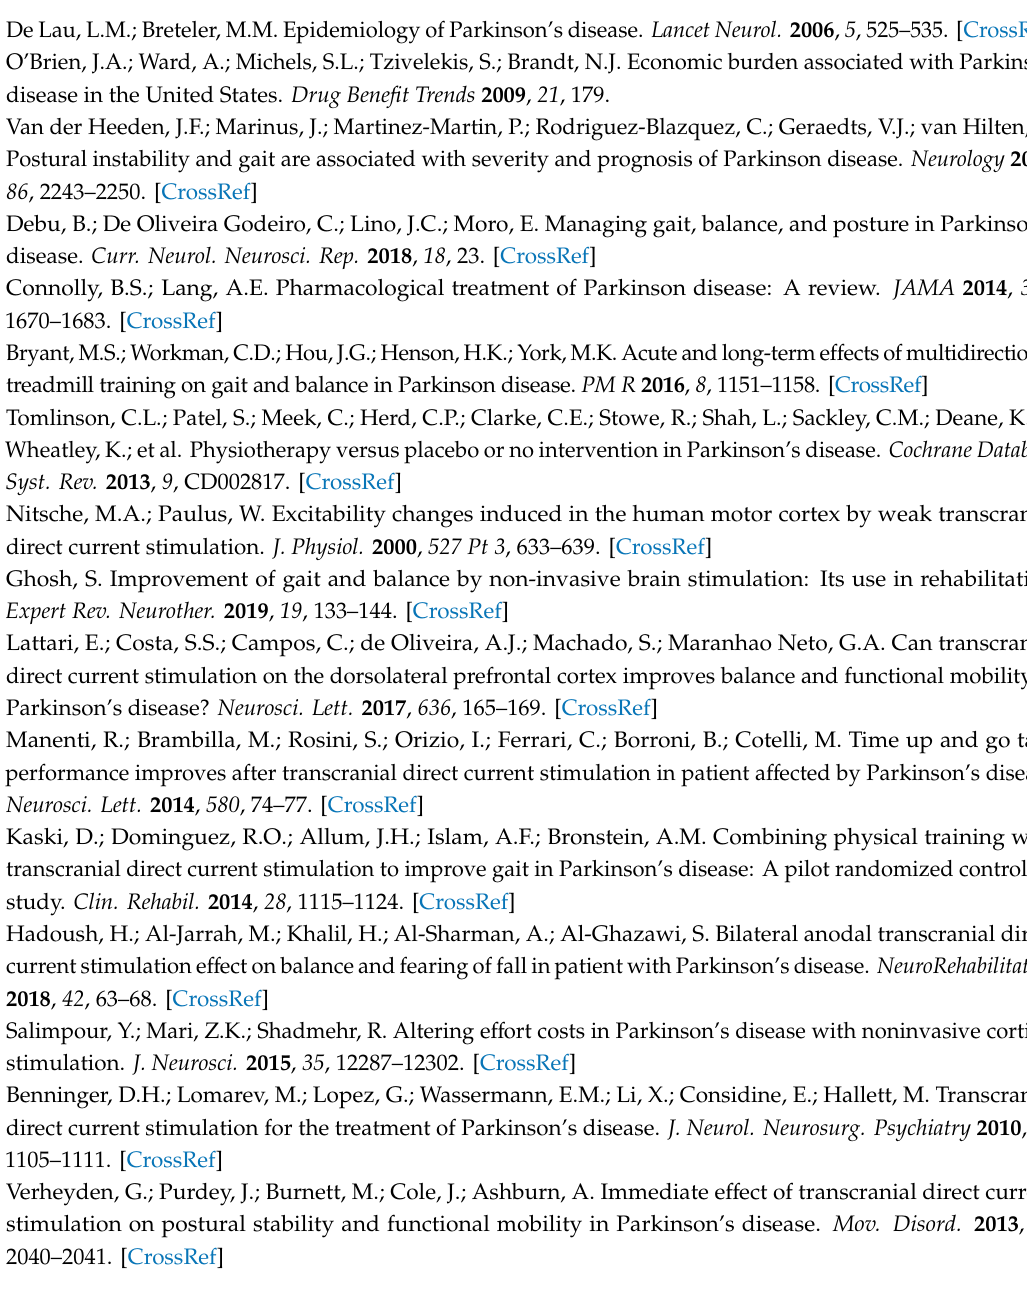
Table S1: Sensation and blinding results, stratified by stimulation intensity and time window during stimulation (beginning, middle,